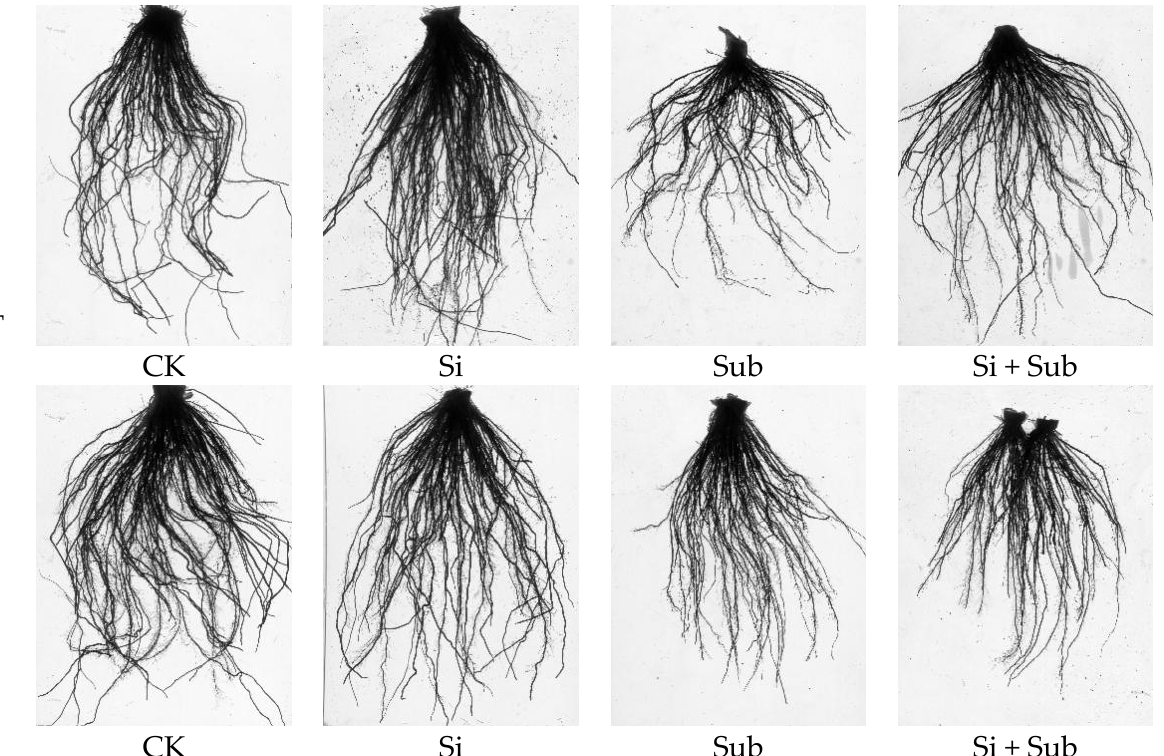
Figure 2. Effects of Si application on phenotypic characteristics of roots under submergence stress. WT, wild type.